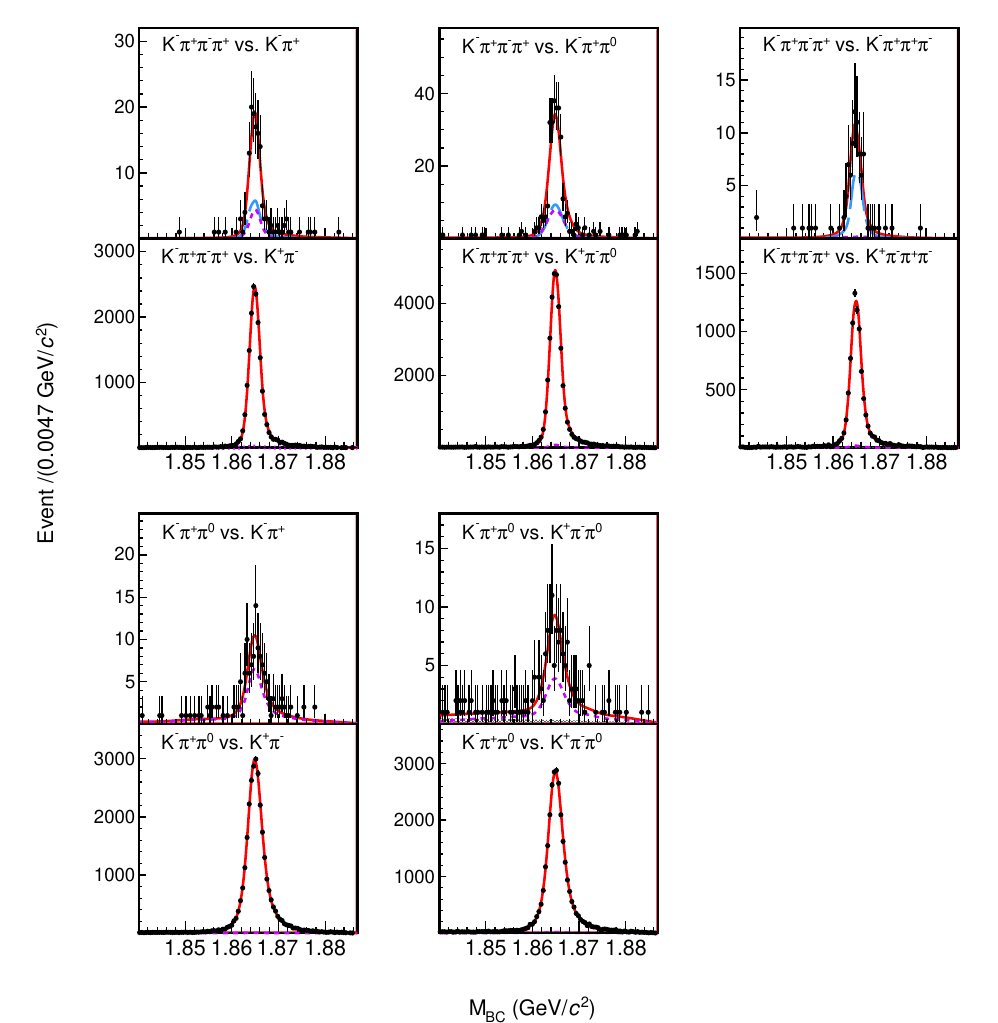
Figure 2 . M BC distributions for the like-sign and opposite-sign flavour tags. The points with error bars are data; the red line indicates the total fit; the long-dashed azure line is the D → K 0 background; the dashed purple line shows the other peaking-background contributions, which in the like-sign case are saturated by doubly misidentified opposite-sign events; the shaded region, which is at a very low level, represents the combinatorial